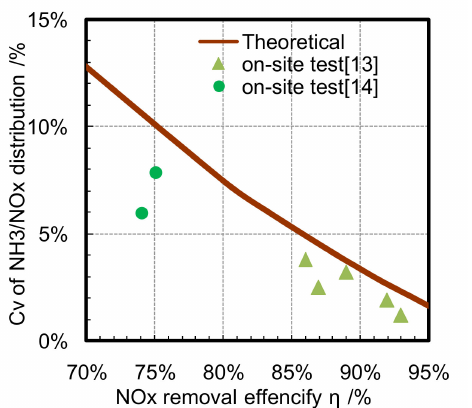
Figure 6. Theoretical and on-site testing comparison of deviation coe ffi cient of the NH 3 / NOX molar ratio distribution ( σ / µ ) (Cv) and NOX removal e ffi ciency (under given ammonia slip).